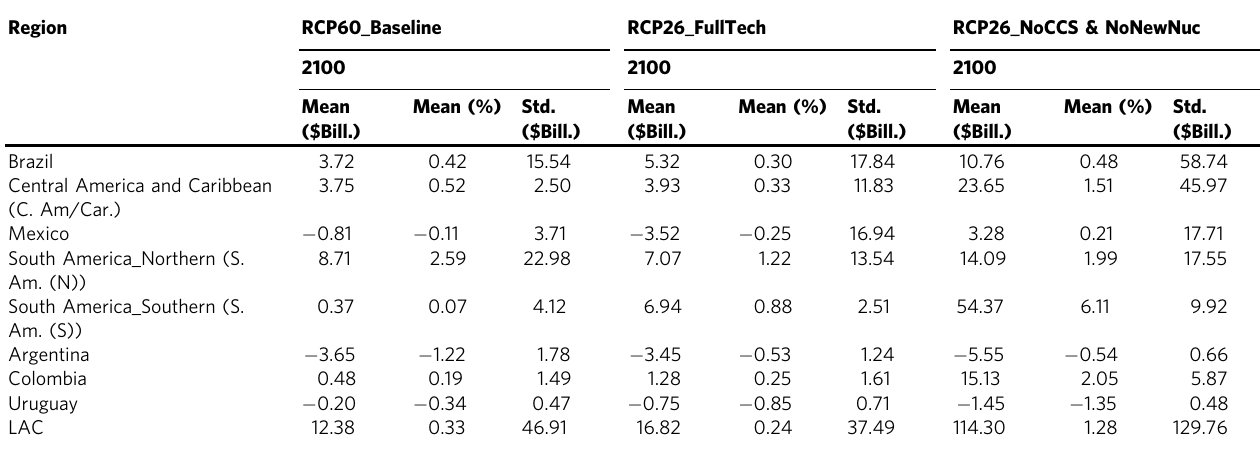
Changes represent the mean value (absolute and percentage) across GCMs (the standard deviationof the absolute model mean change is alsoshown), and are calculated using cumulative investments in the 2020 ─ 2100 period. Changes are relative to the No-Climate impacts scenarios (i.e., positive values mean that scenarios with climate impacts on renewables show increased costs). The corresponding results for the period 2020 ─ 2050 are provided in Supplementary Table 11.